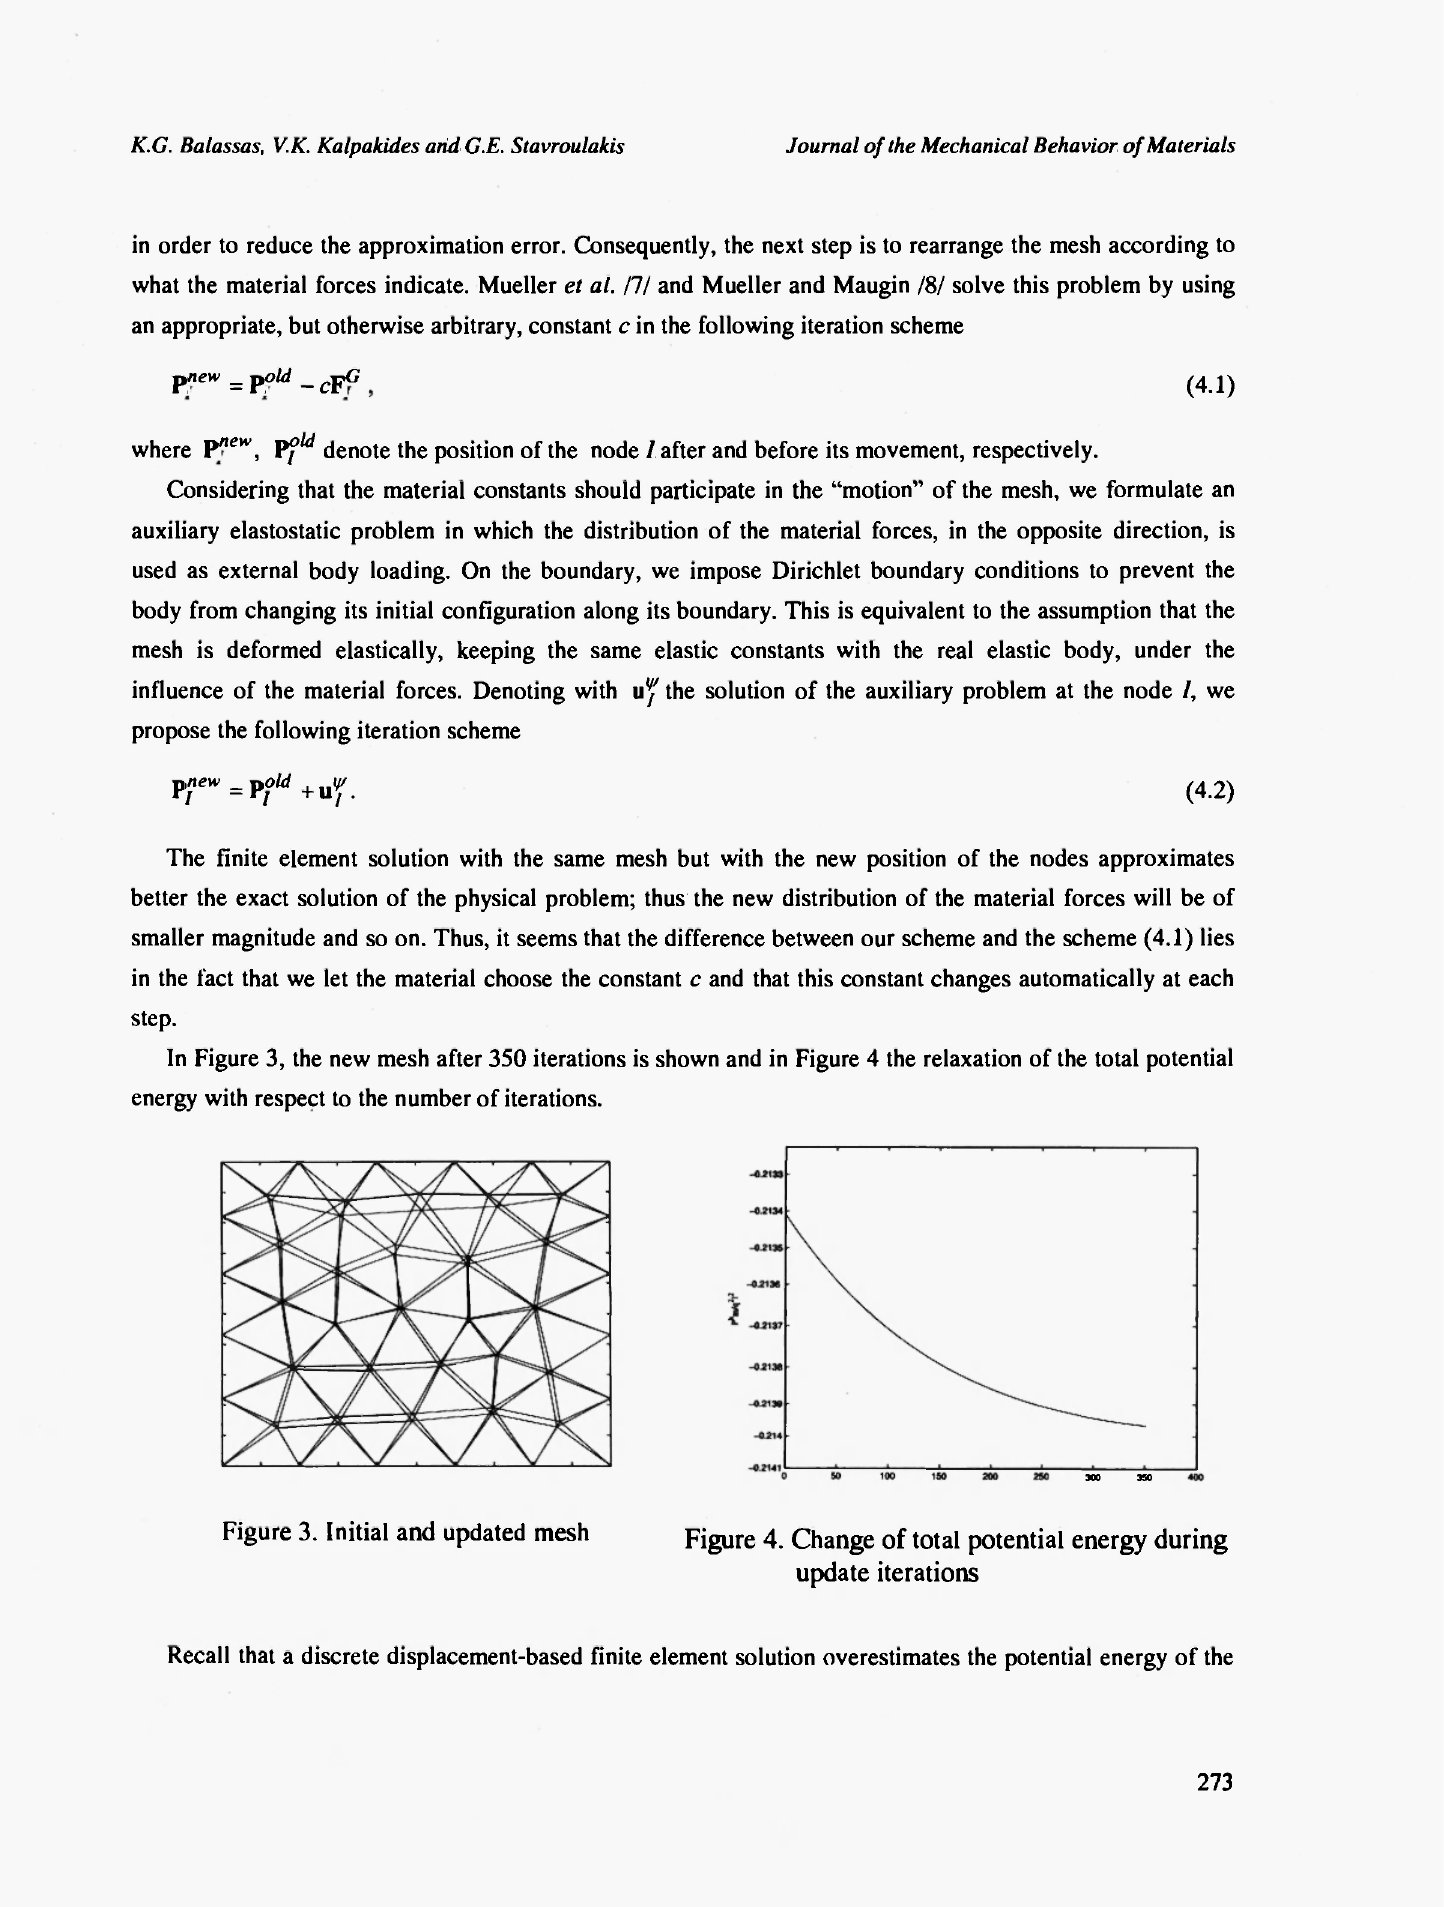
Figure 3. Initial and updated mesh Figure 4. Change of total potential energy during update